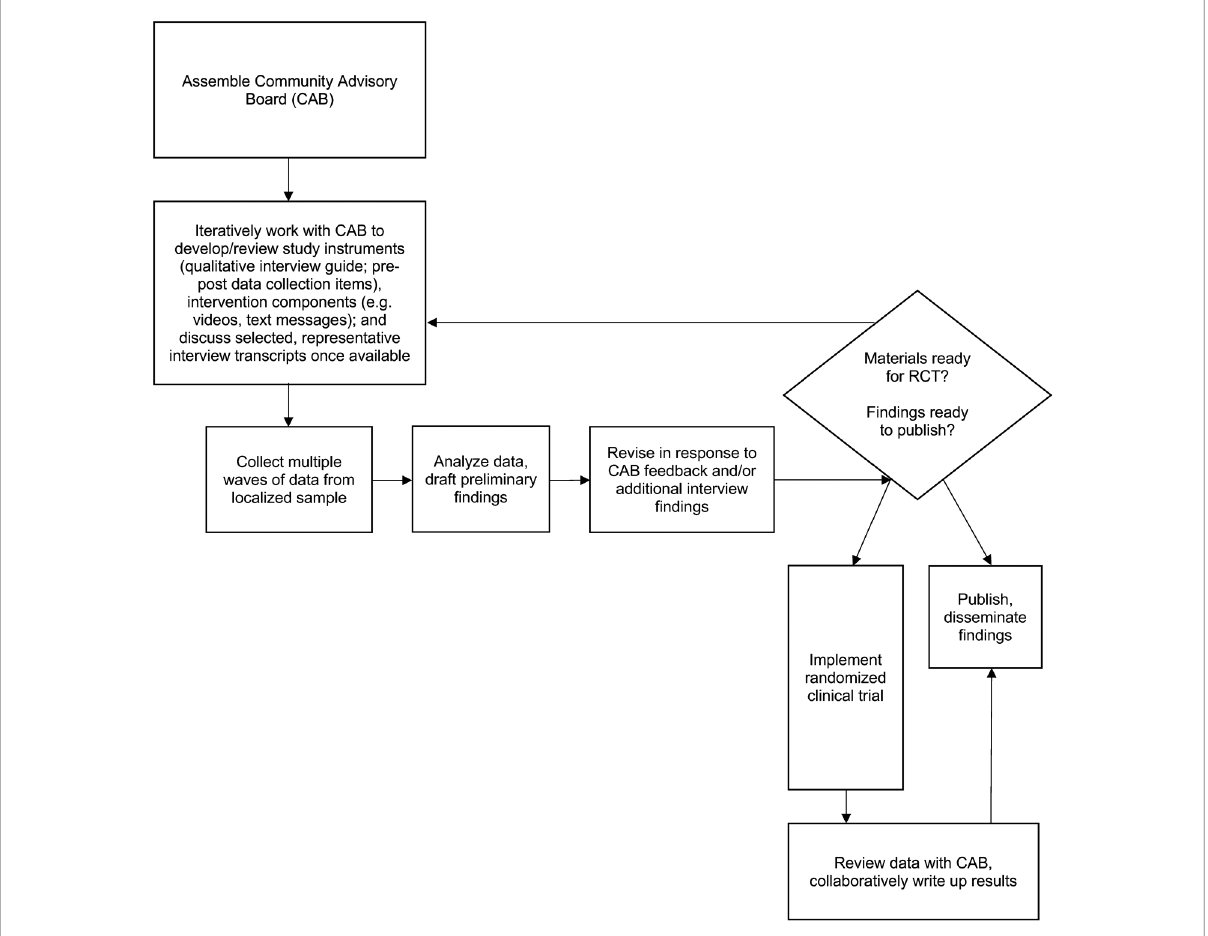
FIGURE 1 Process overview fi